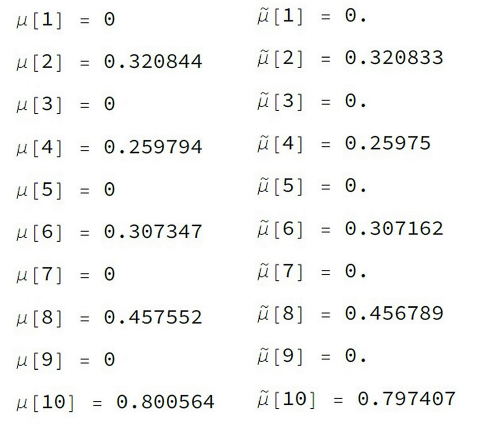
Figure 6. Moments of F ( t ) in (28) as computed using the G-KQR ( left ) and the proposed Bell’s polynomial approximation ( right )